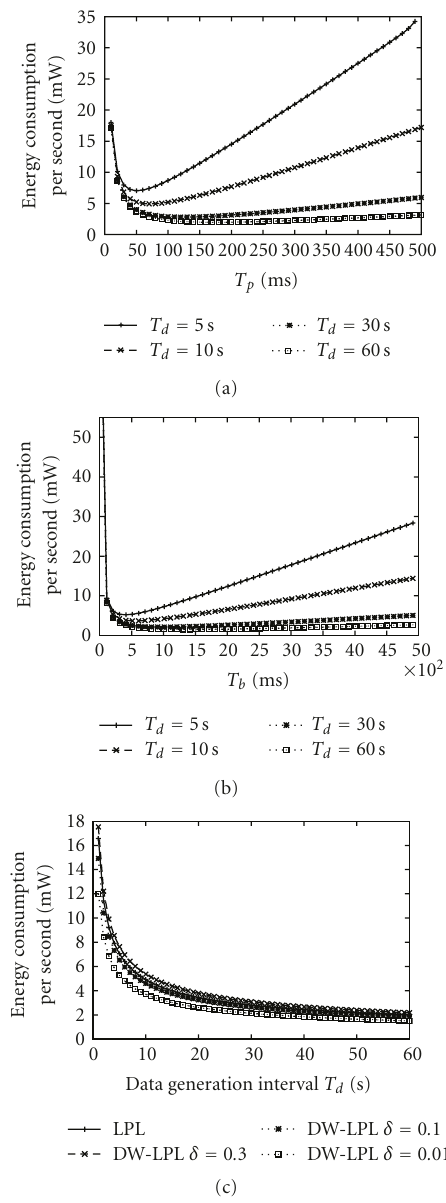
Figure 3: The analysis results for LPL and DW-LPL radio energy model: (a) energy consumption for varying T p in LPL ( n = 10); (b) energy consumption for varying T b in DW-LPL ( n = 10, δ = 0 . 01, T ∗ ); (c) energy consumption comparison for varying R d in p LPL and